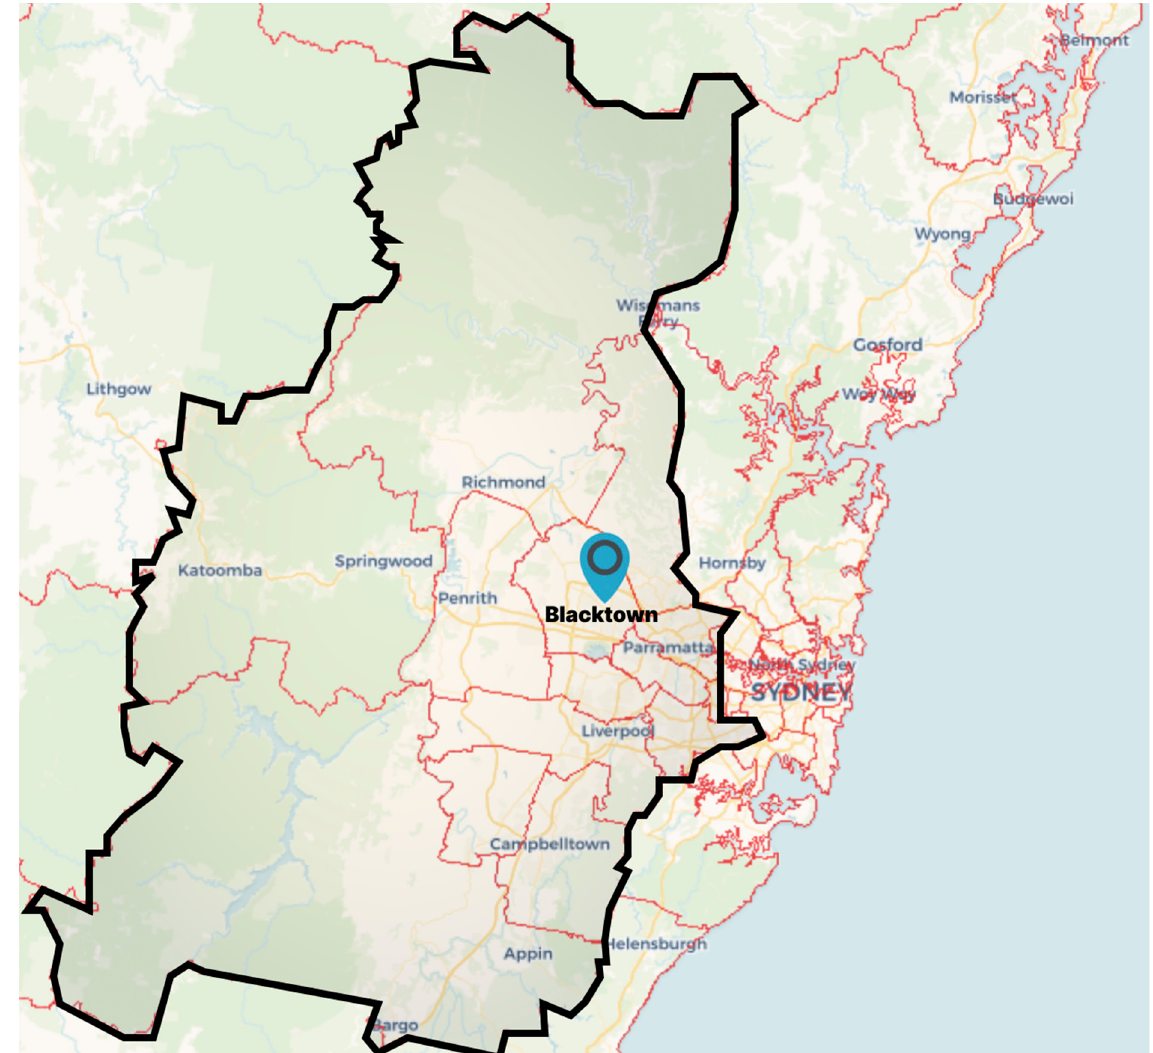
Figure 1. Map depicting Blacktown Local Government Area within Greater Western Sydney. National Map https://nationalmap.gov.au/about.html (accessed on 6 June 2022). Based on data supplied by: Australian Bureau of Statistics © Commonwealth of Australia CC-BY 4.0; © OpenStreetMap contributors ODbL; © CARTO CC-BY 3.0.